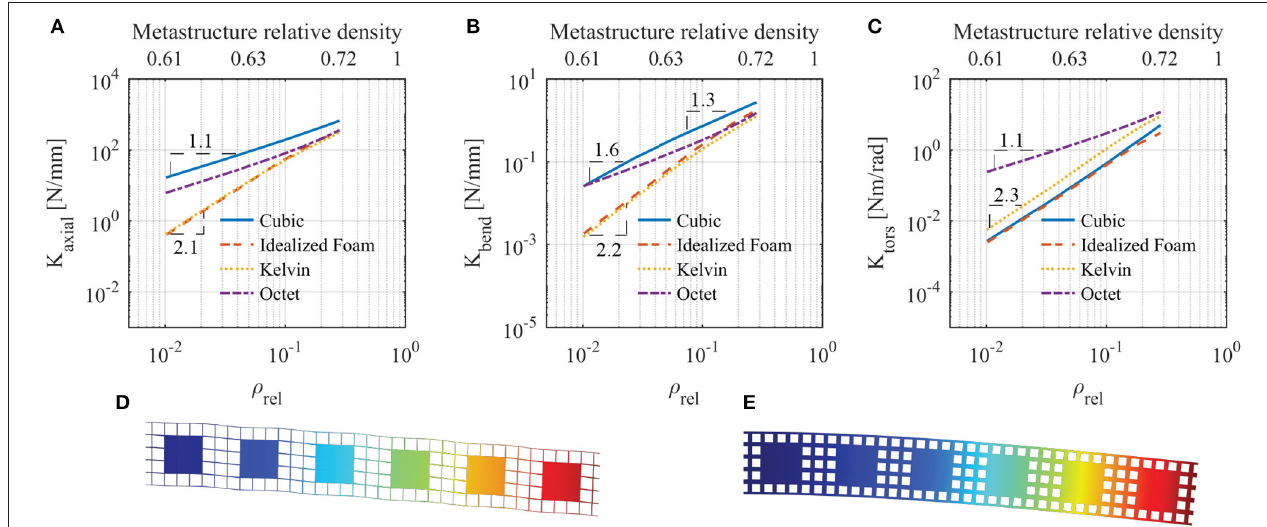
FIGURE 3 | Finite metastructures mechanical properties. (A) K axial (B) K bend (C) K tors (D) Deformation of cubic finite metastructure with 1% relative density under bending. (E) Deformation of cubic finite metastructure with 28% relative density under bending. Metastructure relative densities are shown for comparison.